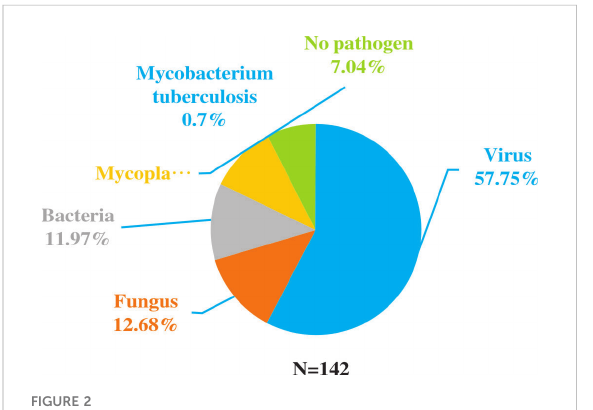
FIGURE 2 Extra pathogens detected by NGS compared to conventional detection methods.